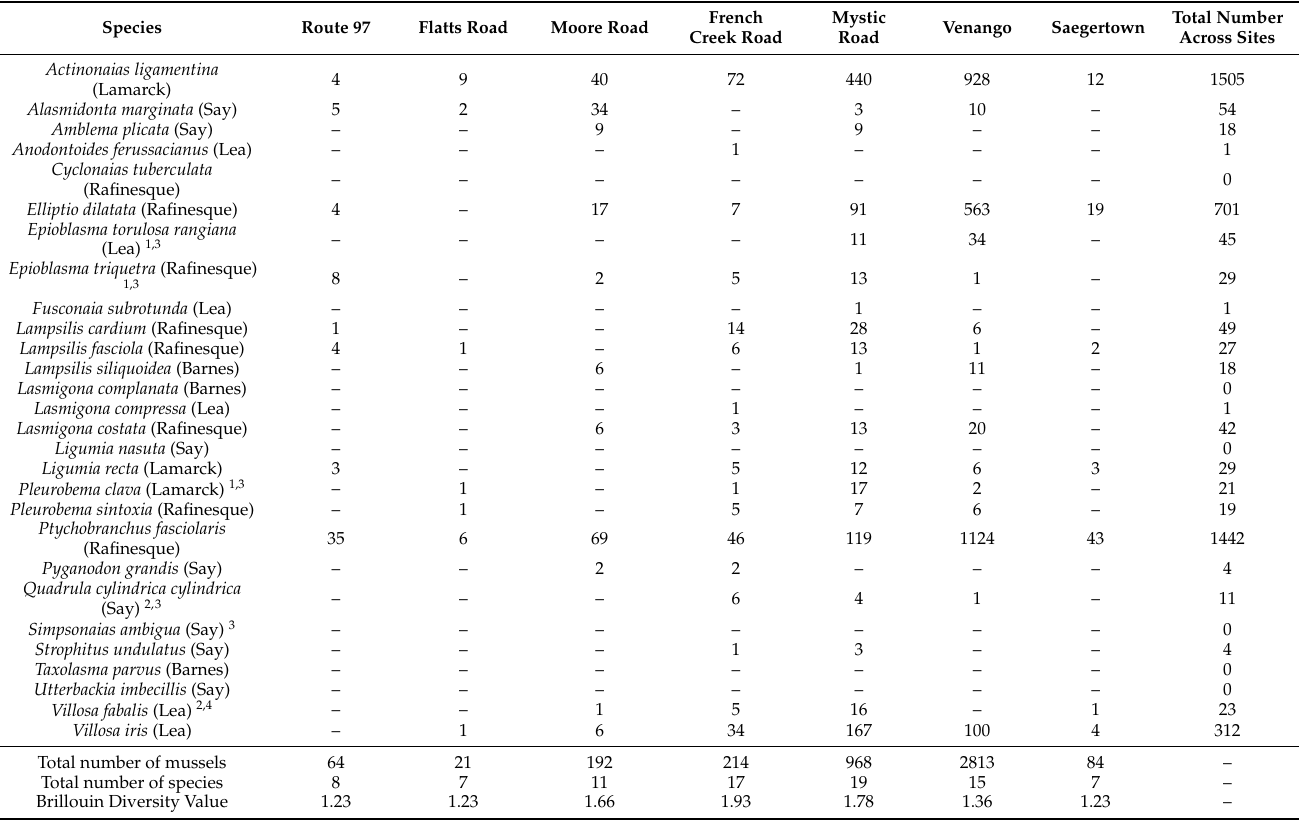
Table 1. Occurrence of freshwater mussel species captured across the French Creek sampling sites. We report the total number of individuals caught over the duration of the study. Further reported are the summary statistics for each site, including the number of mussels and species observed, and their Brillouin diversity index values. Key: – none found,